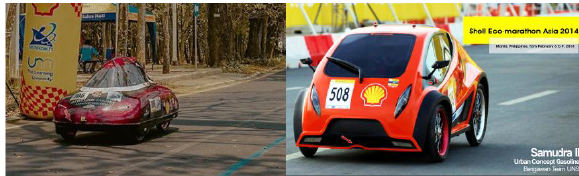
Figure 1: Urban Shell-Eco Marathon vehicle